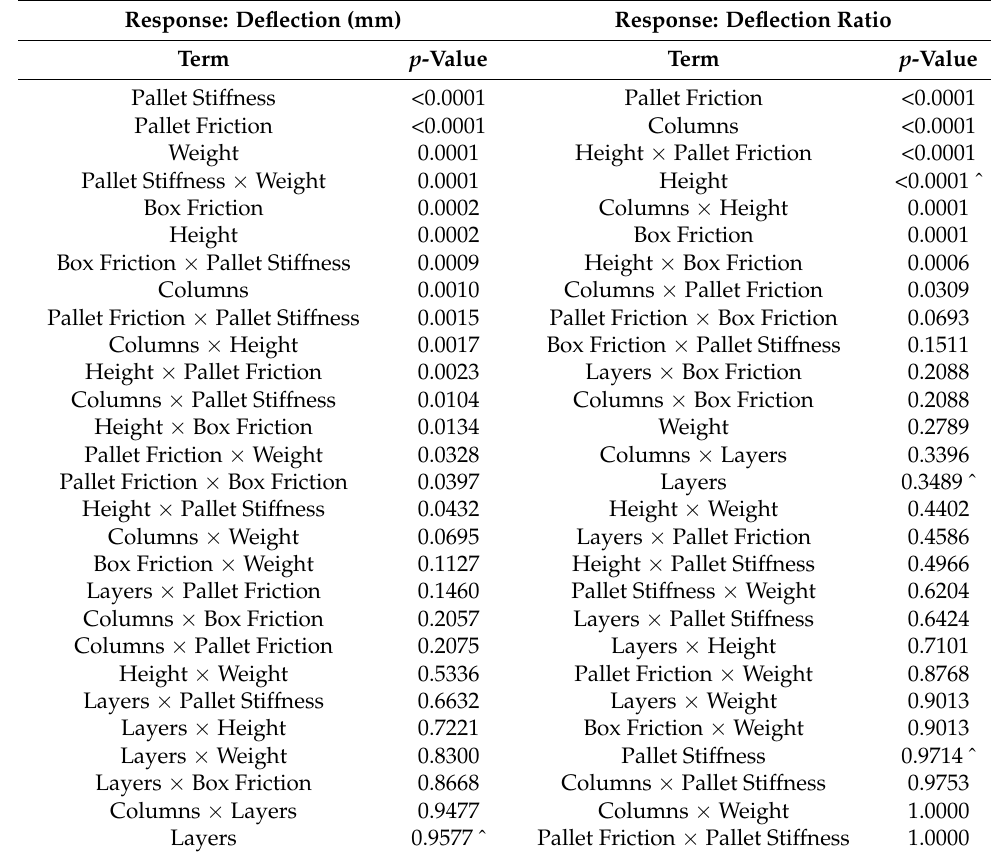
Table 5. Fractional factorial p -values for the factors and 2nd-interactions of the initial screening design by board deflection (mm) and deflection ratio as main response. Factors below divider were considered non-significant ( p -value >